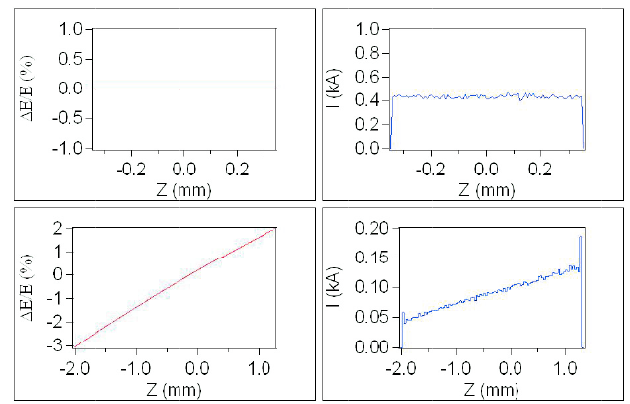
FIG. 3. (Color) Reverse tracking beginning with flat-flat distri- bution at the end of the accelerator (top) and moving towards beginning of the accelerator (bottom).